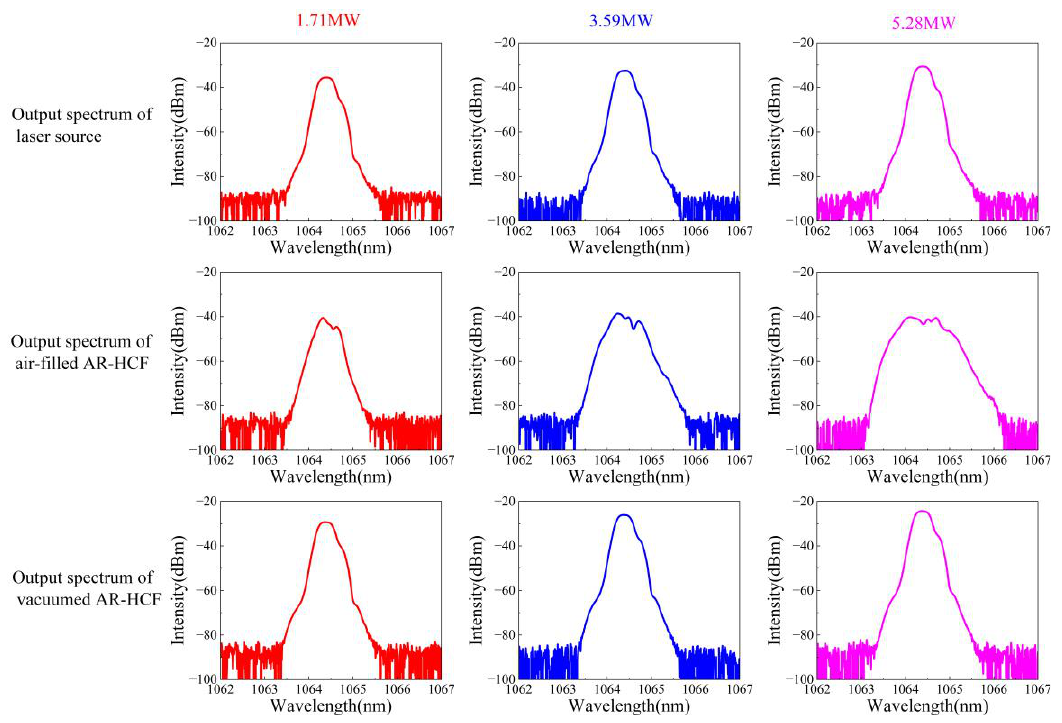
Figure 8. Measurement output spectrum of laser source, air-filled AR-HCF, and vacuumed AR-HCF at peak power of 1.71 MW, 3.59 MW, and 5.28 MW.